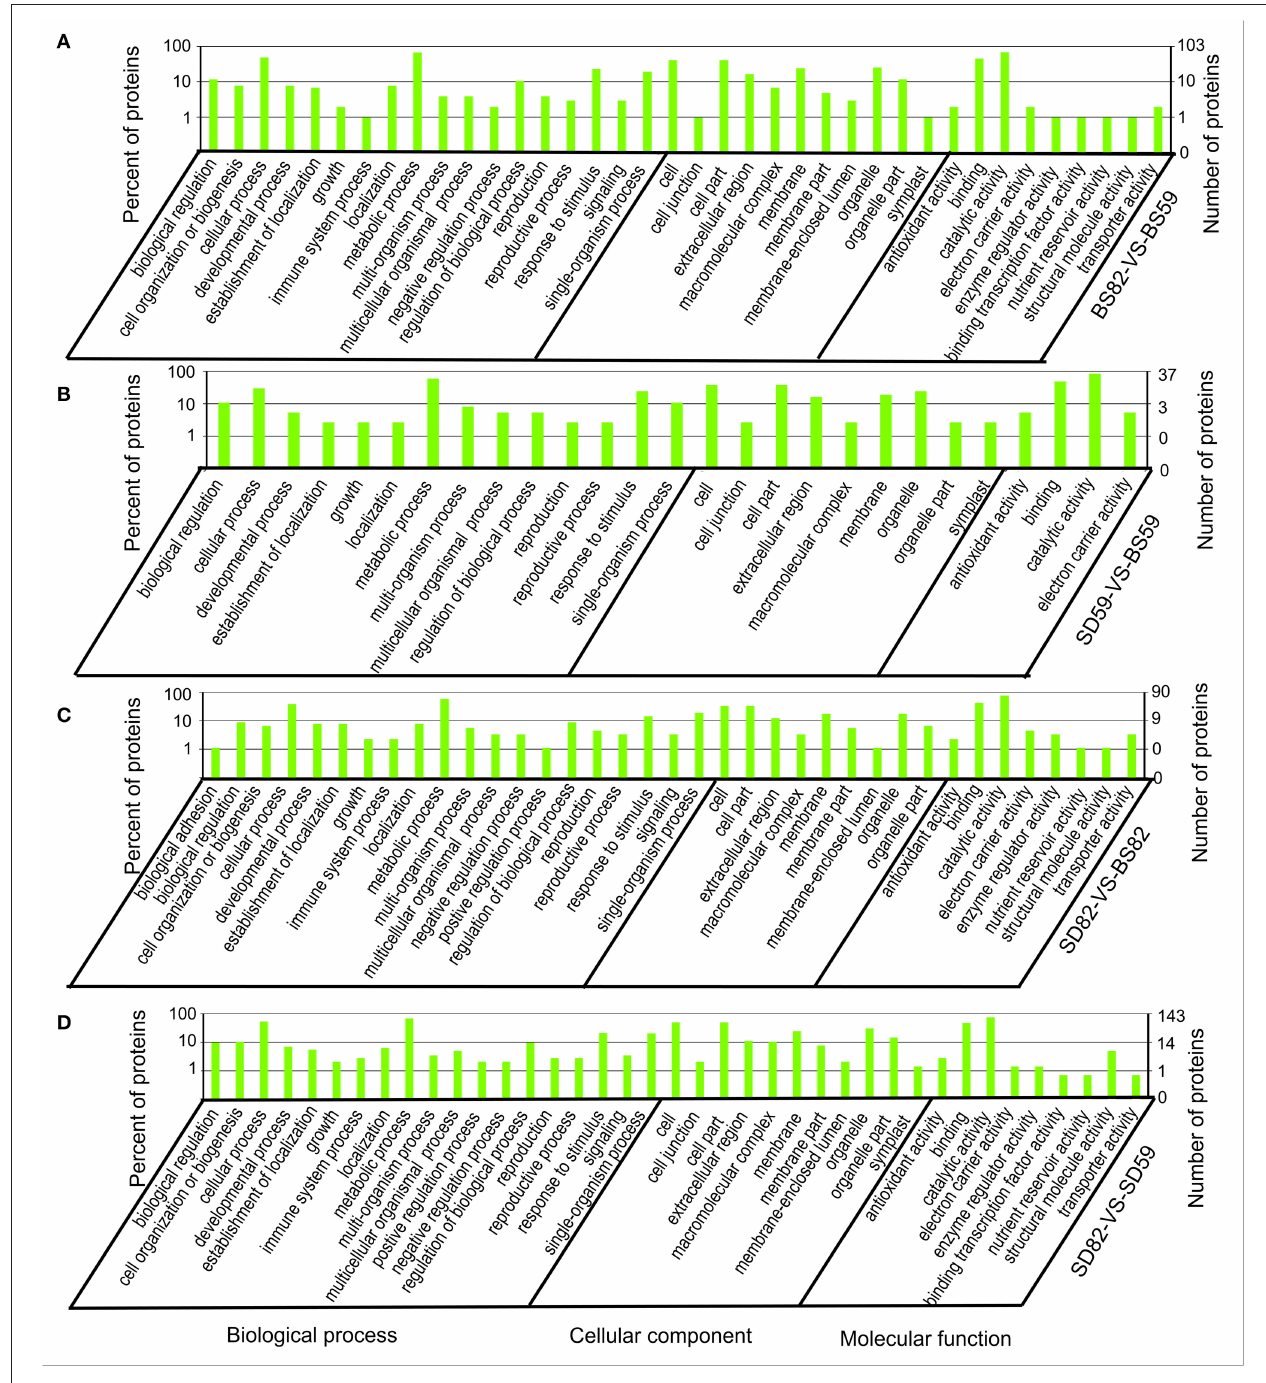
FIGURE 4 | Gene Ontology enrichment analysis of the Cor-DEGs-DEPs (correlated differentially expressed genes and proteins) in the BS82-VS-BS59 (A) , SD59-VS-BS59 (B) , SD82-VS-BS82 (C) , and SD82-VS-SD59 (D)